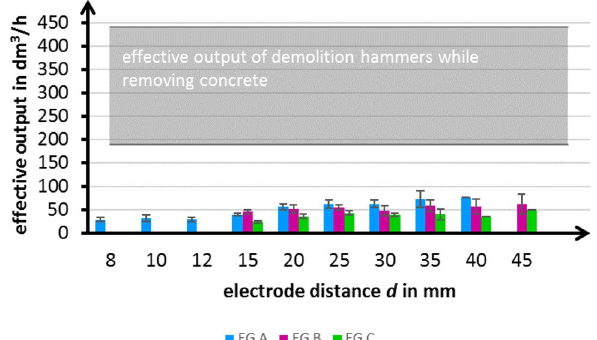
Fig. 8 Effective output as a function of electrode distance and elec- trode